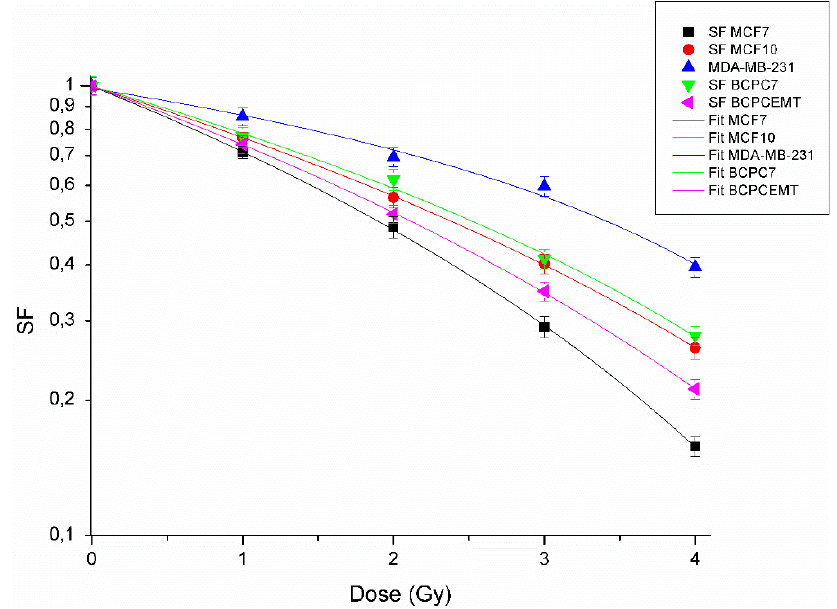
Figure 1. Clonogenic survival curves of breast cancer (BC) cells exposed to different doses of therapeutic X-rays. The data shown represent the mean values plus errors from three independent experiments.